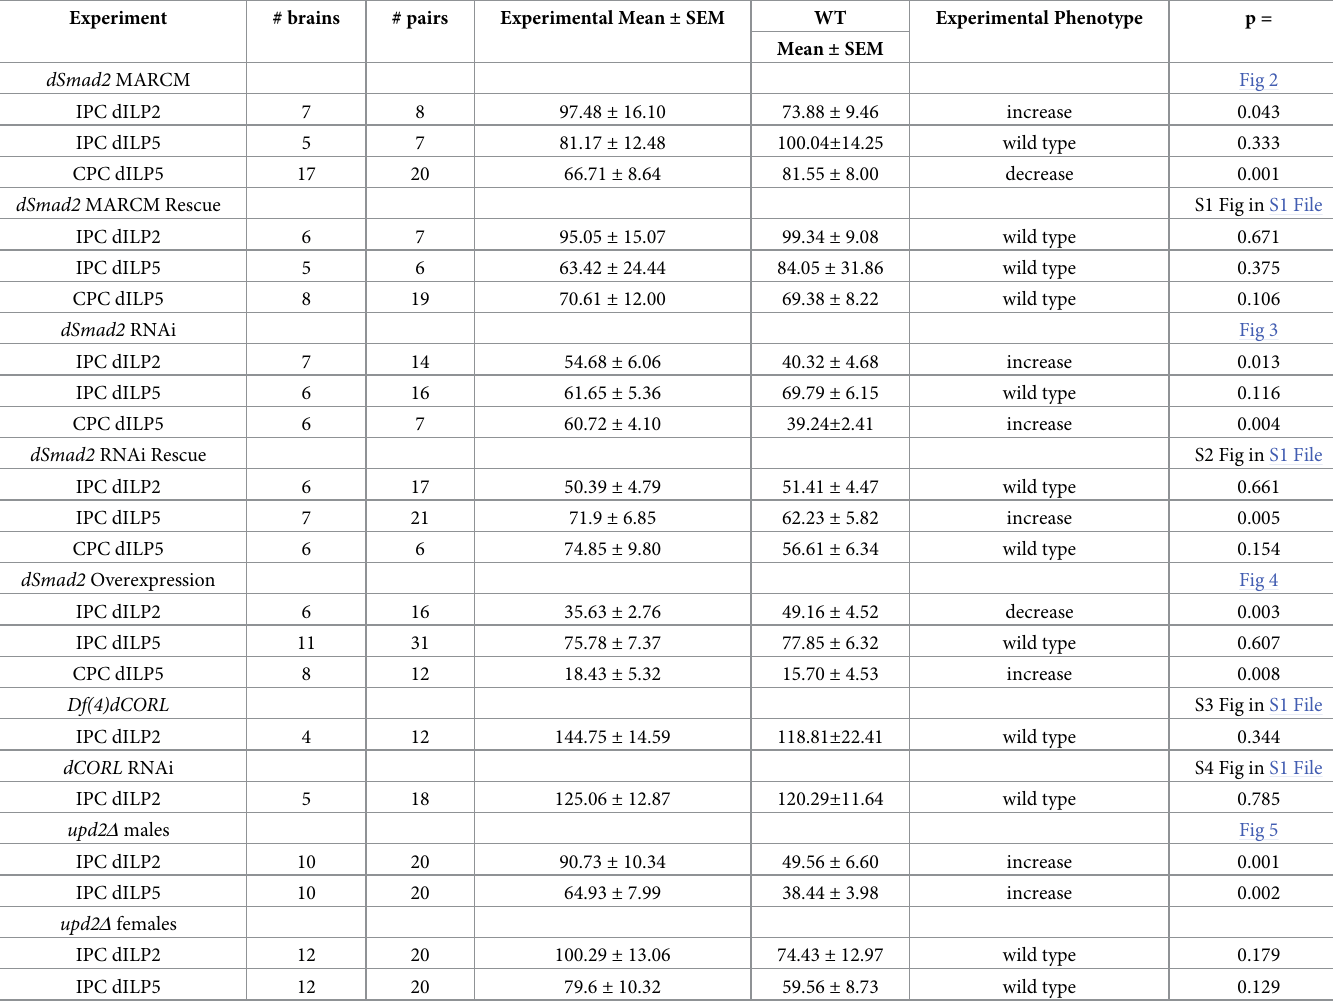
Table 1. Summary of mutant phenotypes for dILP2 & dILP5 pixel intensity in unmated adult female IPCs and CPCs.